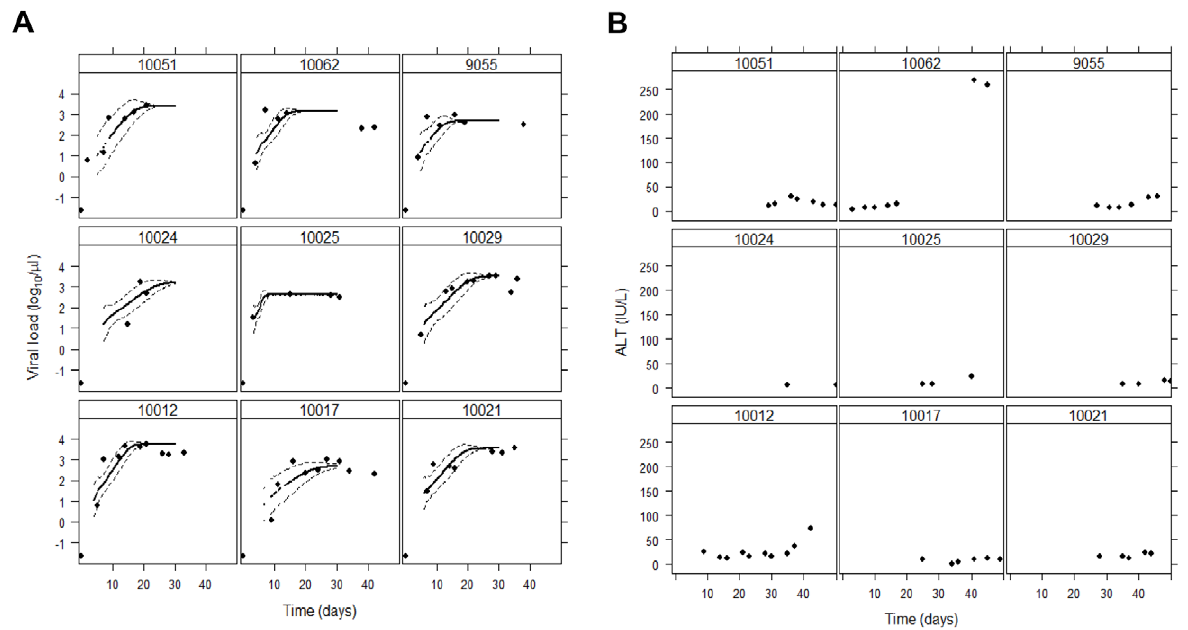
Figure 1. Profile of (A) viral load and (B) ALT in the subjects studied. The black symbols are the observed viral loads, the lines are the simulated trajectories with the model described in methods, and the dashed lines correspond to 95% CI based on 100 simulations. The parameters used for the simulations are given in Table 1. (The first week of increase in virus is very variable due to the stochastic nature of the process, and it is not represented in the graphs.). The profiles of ALT in (B) are about normal (the upper limit of normal – ULN – is , 40 IU/ml [33,34]) and much less than typical later in primary infection, where they can reach 10 6 to 20 6 the normal value [37].